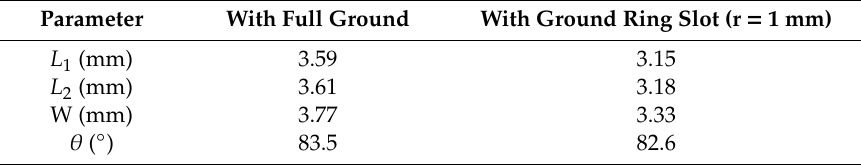
Figure 3. Optimization of the slope of the reflection phase curve of the asymmetric patch element with respect to: ( a ) Variable length ( L 1 ); ( b ) Variable width (W). Table 1. Optimized dimensions of the asymmetric patch element at 26 GHz.